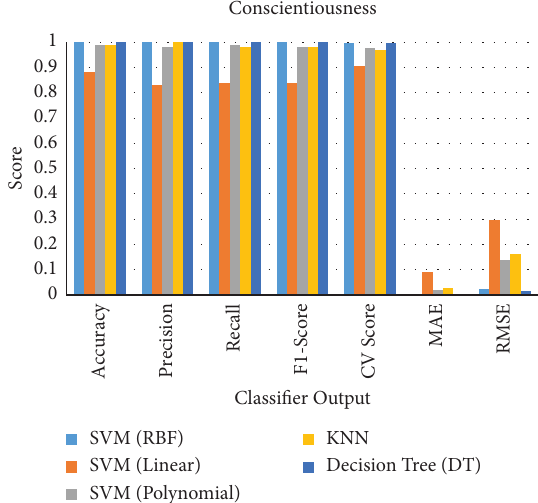
Figure 9: Overall score of the classifcation report, k -fold CV ( k � 10), MAE, and RMSE for the conscientiousness model. Table 17: Comparison with previous